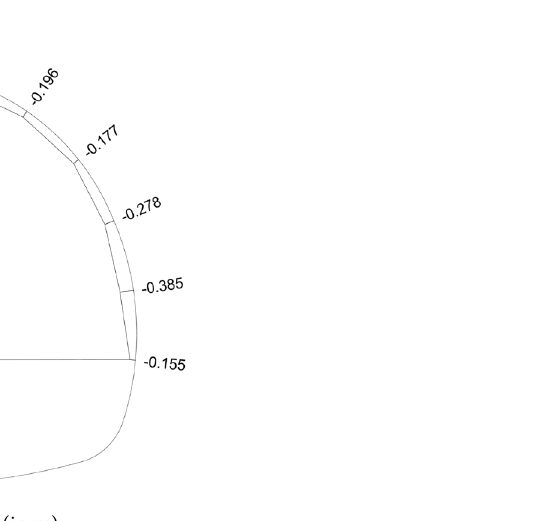
Figure 5. km: 62 + 832 deformation section (in